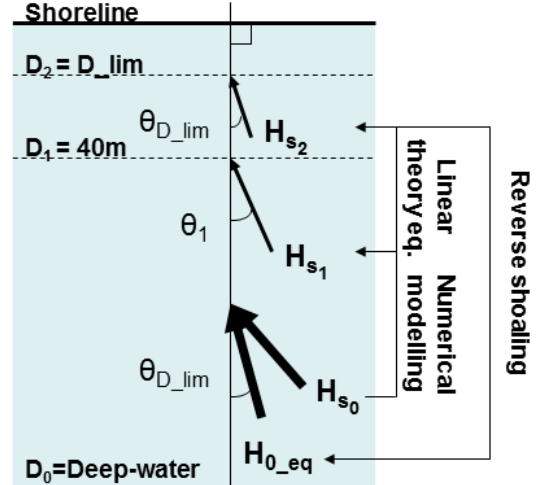
Fig. 7. Positions of the 74 segments into which the Reunion Island coastline has been divided. Fig. 8. Description of the process used to determine the equivalent deep-water wave heights ( H 0 eq ) from the deep-water wave height of the seven scenarios ( H s0 ) using numerical modelling and linear theory equations (Eq. 2 to Eq. 4 in Sect.